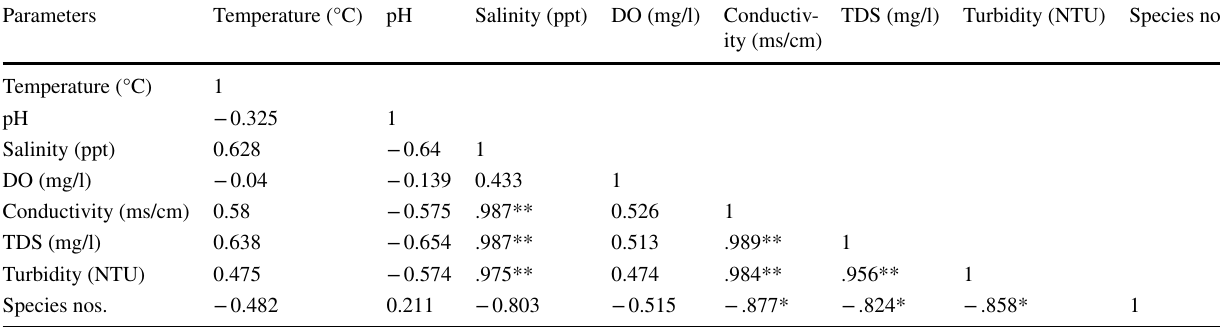
Table 2 Pearson correlation coefficients matrix between the physicochemical parameters of study area